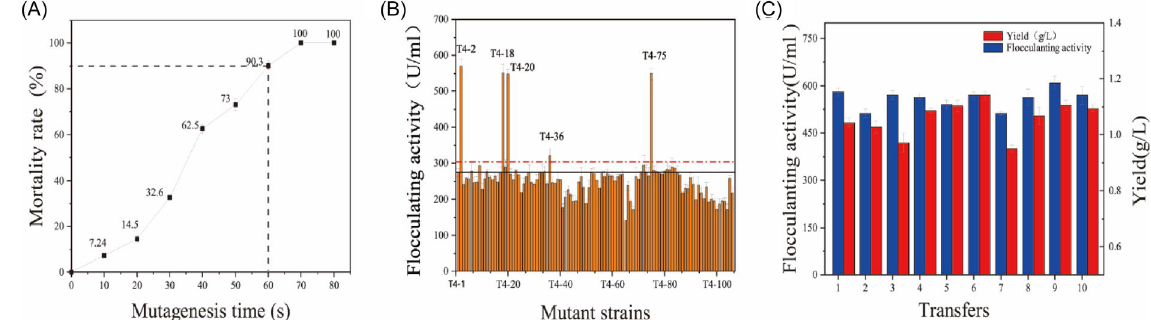
Fig. 1 The lethality rate of strain T4 at different mutagenesis times ( A ), flocculating activity of the isolated mutants after ARTP mutagenesis ( B ) and genetic stability of mutant T4-2 in flocculating activity and EPS production ( C